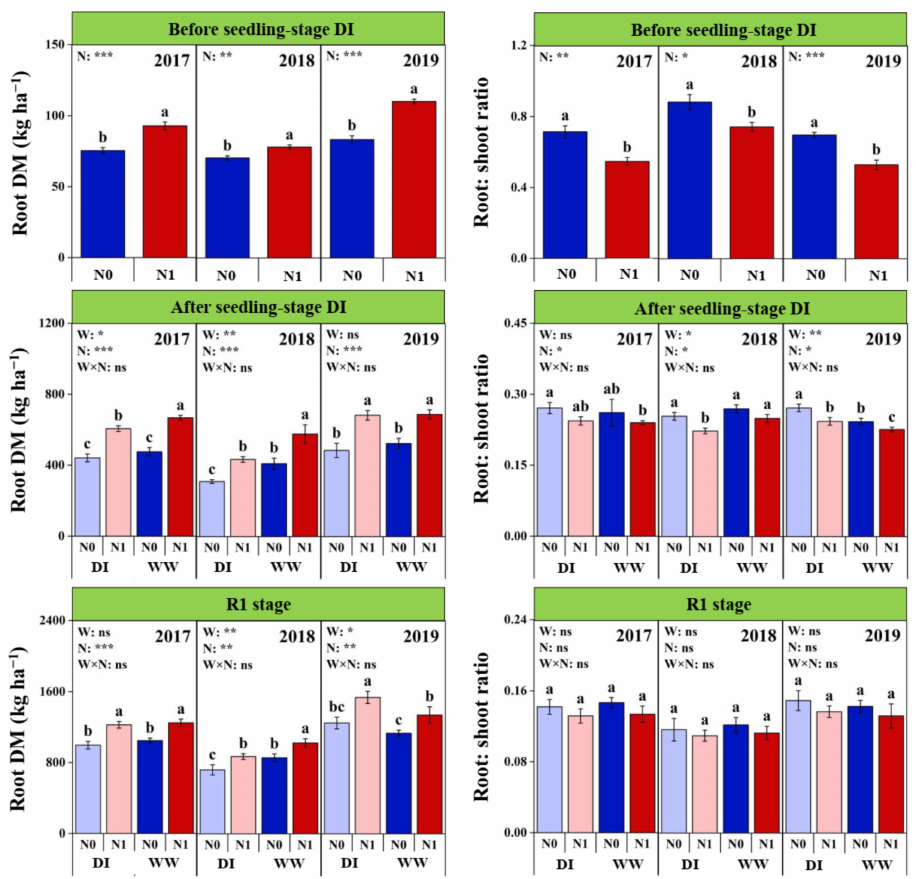
Figure 2. Effects of nitrogen fertilization (N) and seedling-stage water management regime (W) on root dry biomass (DM) and root: shoot ratio of maize plants at different growth stages in 2017–2019. Note: *, ** and *** indicate significance at p < 0.05, p < 0.01 and p < 0.001, respectively, and ns indicates non-significance ( p > 0.05). Different letters above bars indicate significant differences between treatments ( p <